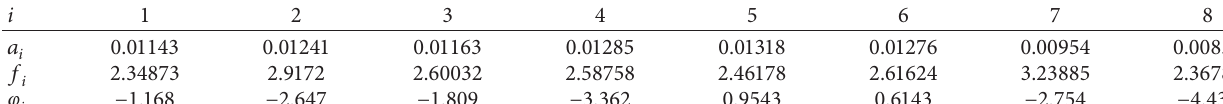
Table 8: Values of 24 fitting parameters in equation (1) in 140 ∼ 160s.